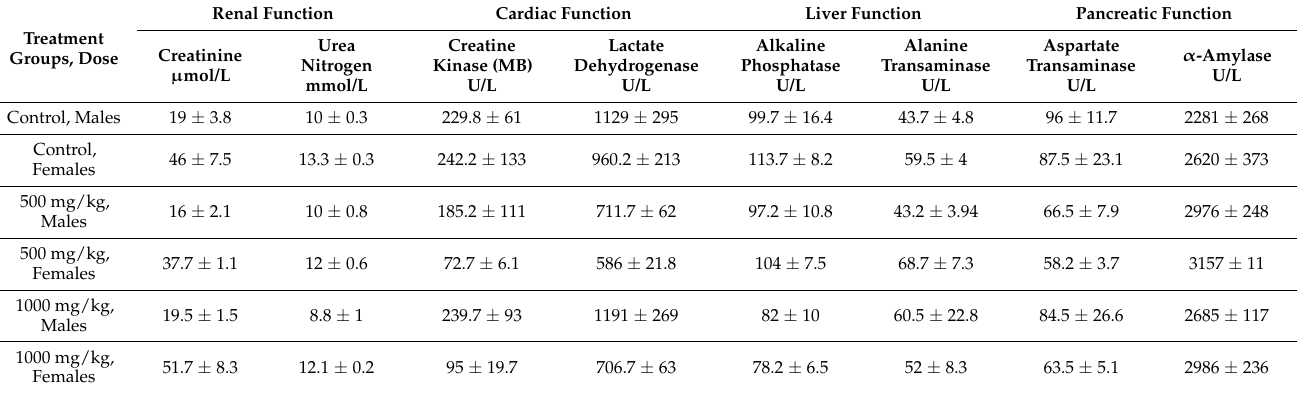
Figure 3. Assessment of the toxicity of MCFS nanoparticles. ( a ), Flow cytometry of MMTV-PyMT mouse breast cancer cells either untreated (control), treated with 55 mM of MCFS nanoparticles, or 1 µ m of STS in the presence of annexin V-PE and stained with propidium iodide. ( b ), Hematoxylin and eosin staining of tissues from mice treated with different concentrations of MCFS. Lung, kidney, liver, and spleen collected from mice 14 d after injection of 500 mg/kg MCFS or 1000 mg/kg MCFS nanoparticles in stabilizing buffer. Samples were dehydrated, embedded in paraffin, sliced to 5 µ m sections, and stained by hematoxylin and eosin. Scale bar = 100 µ m. Table 1. Renal, cardiac, liver, and pancreatic functions in mice after systemic infusion of MCFS